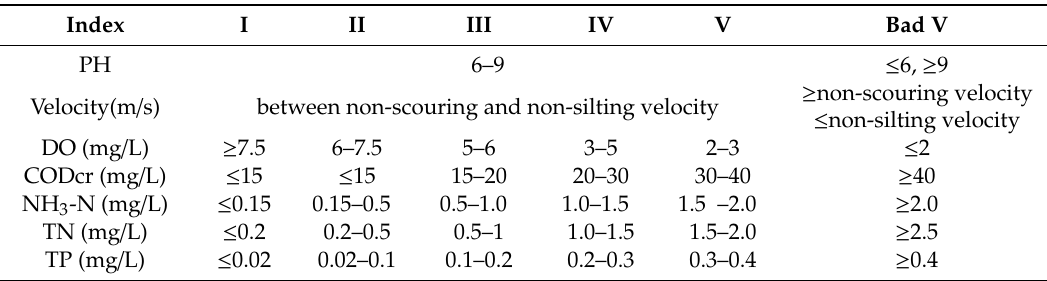
Table 3. Assessment